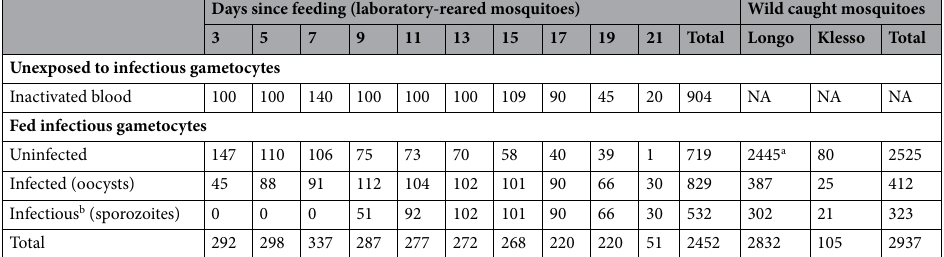
Table 1. The number of laboratory and field mosquitoes analyzed. All data were Anopheles coluzzii mosquitoes infected with wild strains of Plasmodium falciparum. a Blood source unknown as mosquitoes were collected potentially exposed. b All infectious mosquitoes were classified as also infected (whether or not oocysts were